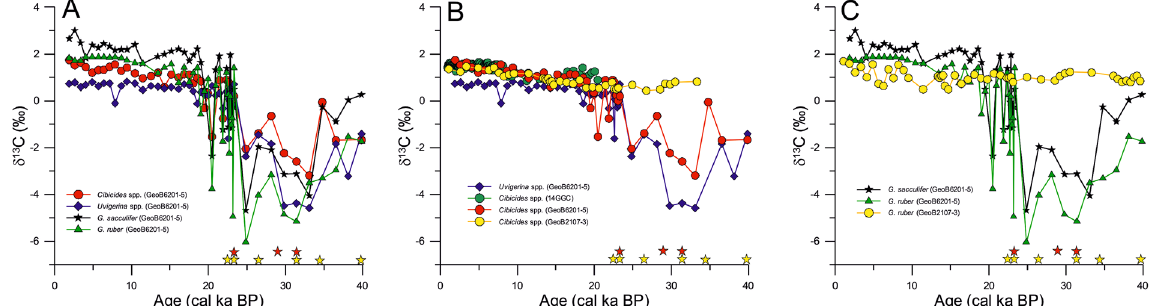
Figure 2. Methane release from southern Brazilian margin during the last glacial period. ( A ) Downcore benthic and planktonic foraminifera δ 13 C records from the seep core GeoB6201-5 showing the strong δ 13 C depletion between 40 and 20 cal ka BP. ( B ) Comparison of benthic foraminifera Uvigerina spp. and Cibicides spp. δ 13 C records from seep core GeoB6201-5 and adjacent non-seep cores GeoB2107-3 and 14GGC 30 . ( C ) Comparison of planktonic foraminifera Globigerinoides ruber and Globigerinoides sacculifer δ 13 C records from seep core GeoB6201-5 and adjacent non-seep cores GeoB2107-3. Stars in the bottom indicates depth with presence of High-Mg calcite derived from XRD (Red stars) and presence of Mg derived from SEM-EDX (Yellow